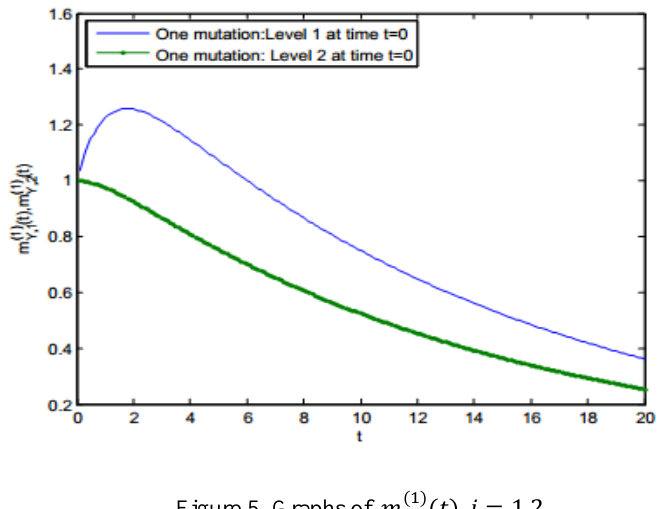
Figure 5. Graphs of 𝑚 𝑌,𝑗(1) (𝑡), 𝑗 =